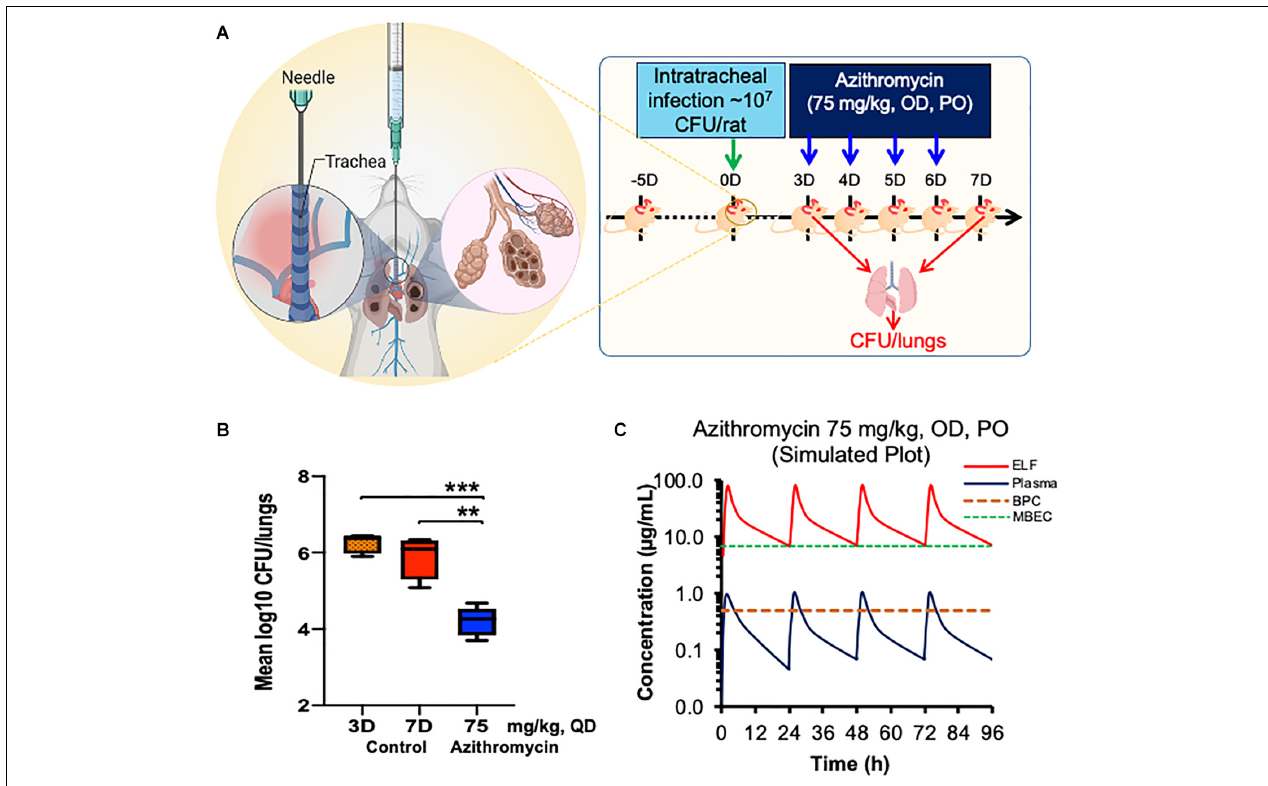
FIGURE 4 | Efficacy of azithromycin in chronic rat pulmonary infection model of P. aeruginosa PA-14.Chronic pulmonary was caused using P aeruginosa PA-14 in rats via the intratracheally route and treatment was started 3 days post infection with azithromycin by PO route (A) . Bacterial lungs loads were determined post 22 h of last dose and compared with those of placebo treated (B) . Stimulated plasma and ELF concentration of azithromycin at 75 mg/kg, PO for 4 days was calculated using WinNonlin (C) . The asterisks indicates a significant difference compared with those of control group ( **P < 0.01, ***P < 0.001). CFU, Colony Forming Unit; OD, Once a Day; PO, Per Orem (Oral administration); ELF, Epithelial Lining Fluid; BPC, Biofilm Preventive Concentration; MBEC, Minimal Biofilm Eradication